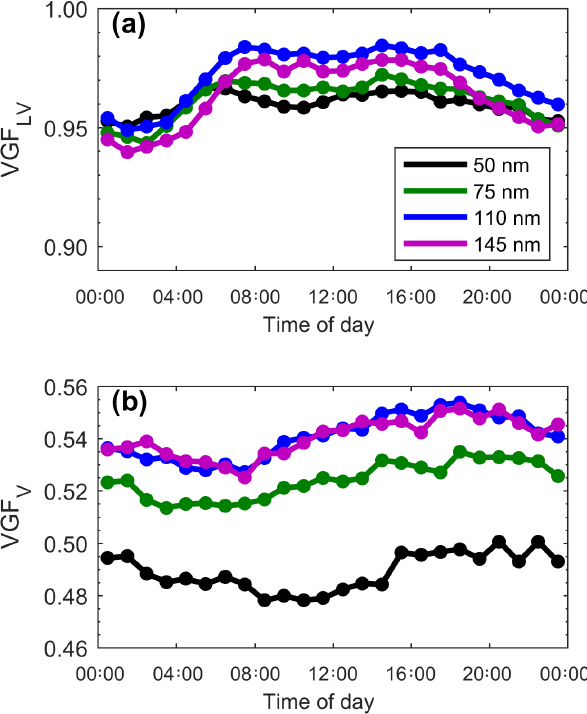
Figure 5. Mean diurnal variation of the volatility diameter growth factors for the less volatile mode (VGF LV ; a ) and volatile mode (VGF V ; b ) for different dry particle diameters. The panels have shared